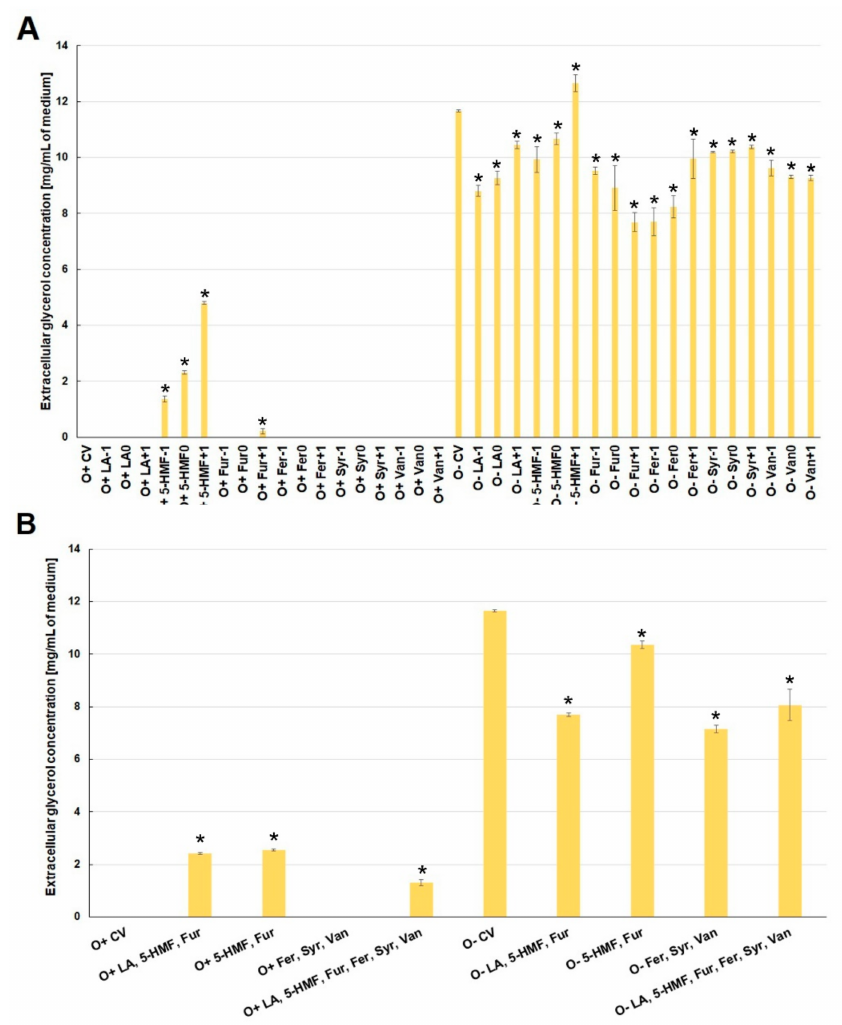
Figure 6. Effect of lignocellulose pretreatment by-products ( A , B ) on the production of extracellular glycerol by yeast (*—statistically different from the corresponding control variant α <